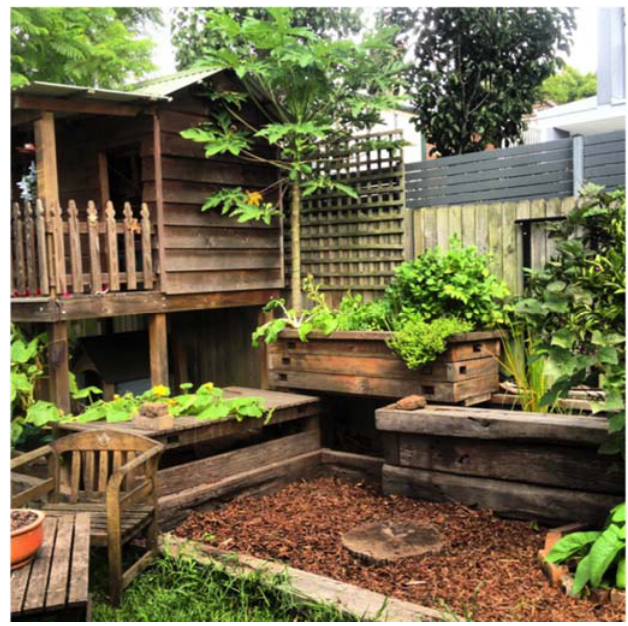
Figure 2. Photo of wooden backyard aquaponics system. Reproduced with permission from Justine Williams (City Food Gardens).